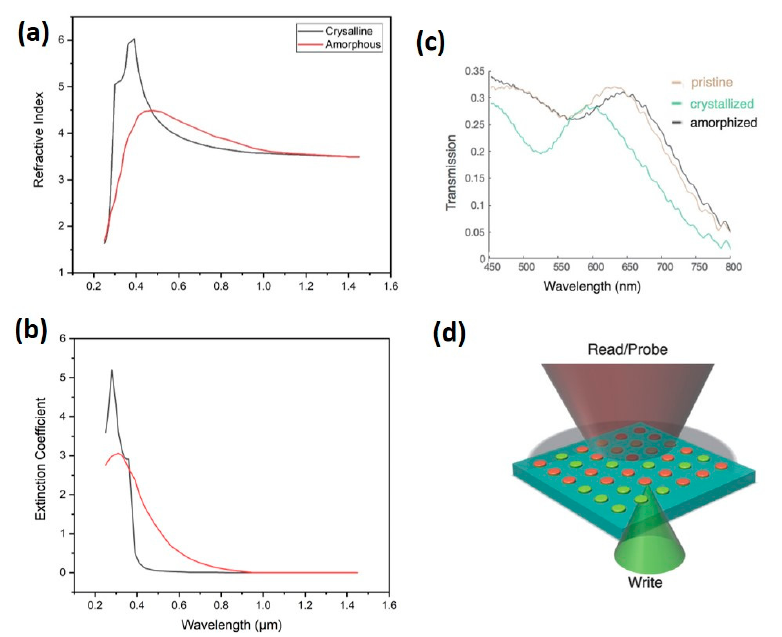
Figure 4. ( a ) Refractive index and ( b ) extinction coefficient of silicon in the crystalline and amorphous states showing a large change in refractive index and extinction coefficient in the UV and near-UV region, which is reduced to an insignificant difference as it reaches 1.5 µm [27,28]. ( c ) Transmission spectra of pristine a-Si nanodiscs, crystallized nanodiscs, and re-amorphized nanodiscs with 215 nm in diameter. ( d ) The conceptual pixel-addressable rewritable metasurface for optical wavefront control. (( c , d ) Reproduced with permission [29]).